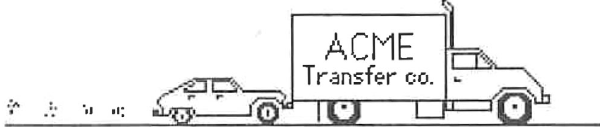
FIG. 3. FCI Question 15 [1]. A car is pushing on a truck and both accelerate to the right. This questions asks students about how the force from the car on the truck relates to the force from the truck on the car. The proposed Newtonian ordering for this question is given as E < D < B < C <